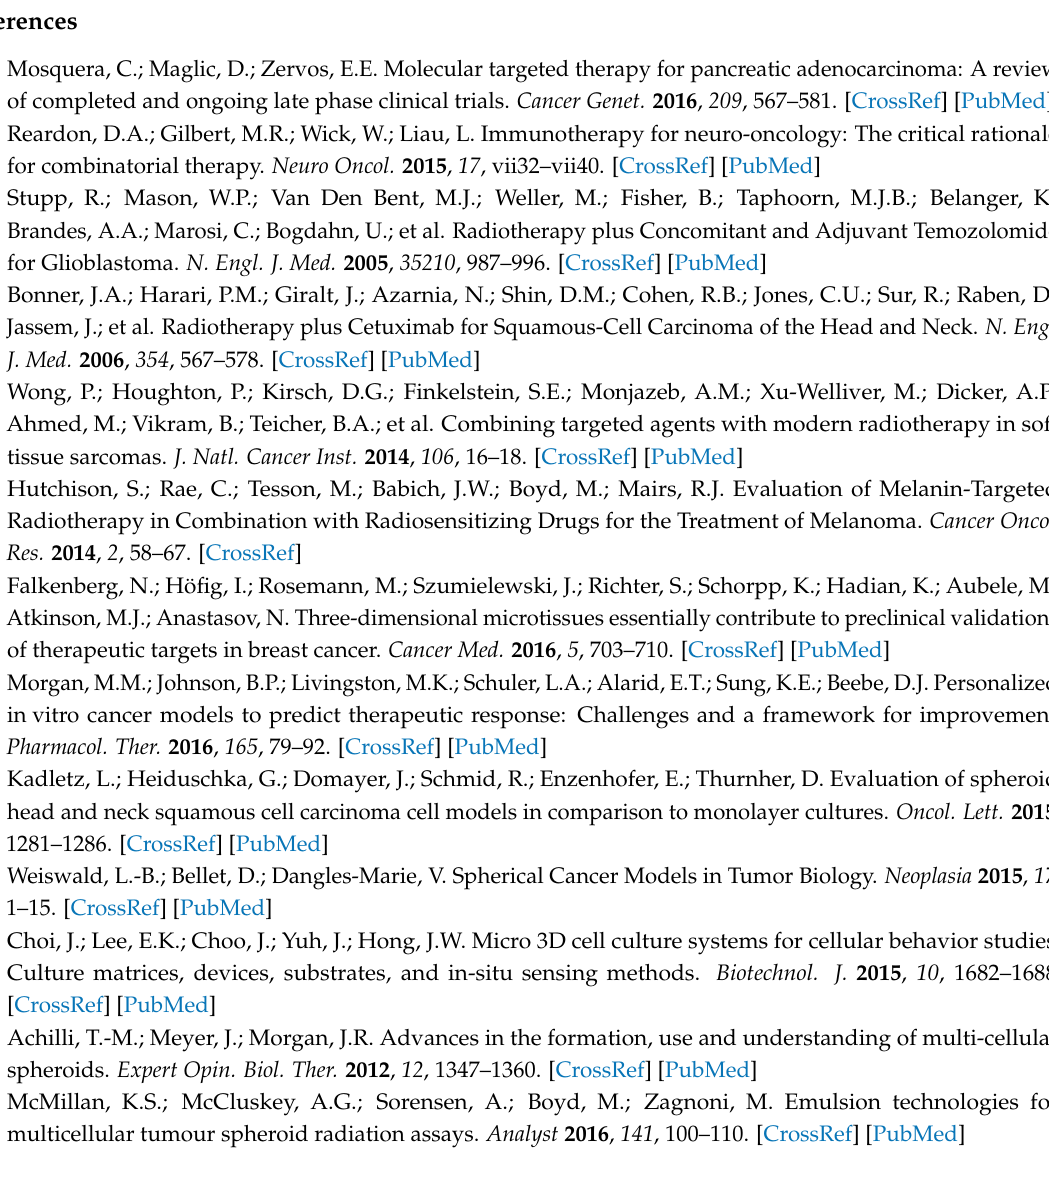
Table S1—Valve resistance data, Video S1—Flow control experiment with aqueous dye